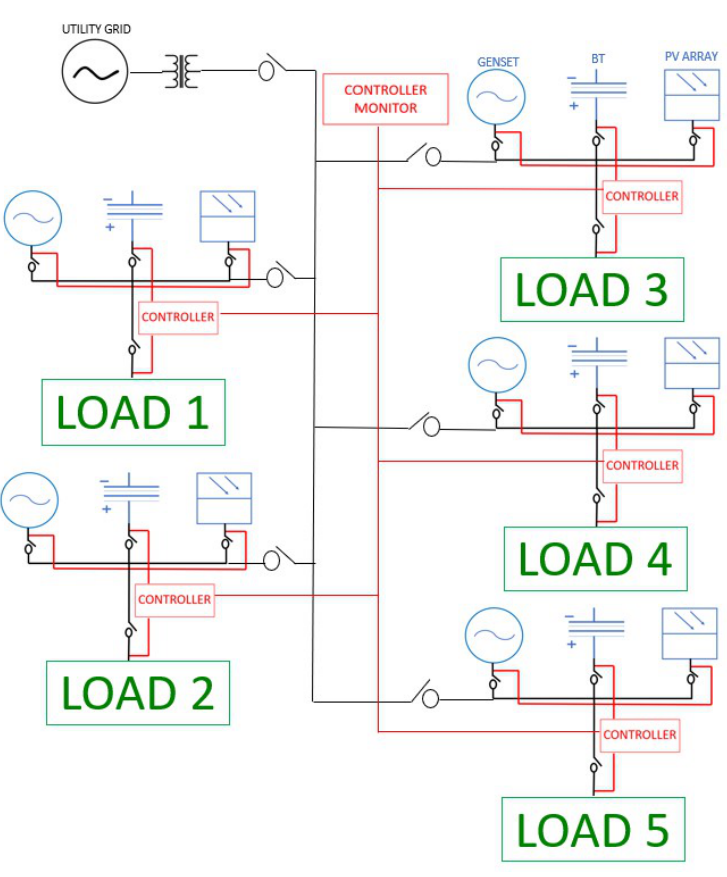
Figure 5. Microgrid and Nanogrid Design. This one-line diagram represents the overview of the chosen nanogrid architecture highlighting the amount of loads, DERs, and controller